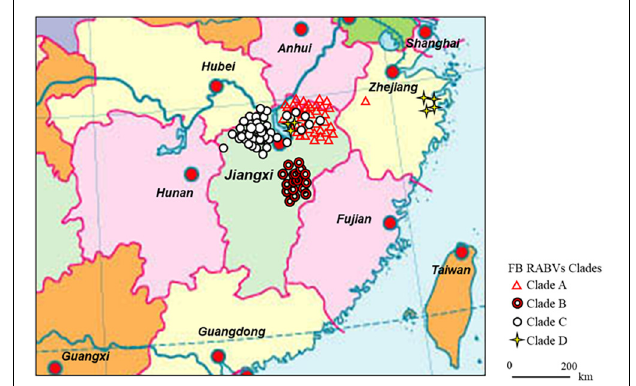
FIGURE 1 | Continental distribution of ferret badger (FB) rabies virus (RABV) isolates in southeast China during 2008–2018. The 41 FB RABV isolates in Lineage A were mainly distributed in Qiandao lake (Zhejiang province) and east Poyang lake (Jiangxi province) regions. Lineage B had 17 isolates from Fuzhou district, south of Poyang lake. Lineage C included 47 isolates, 41 distributed in west Poyang lake, and the other 6 in east Poyang lake, mixing geographically with Lineage A. Lineage D had 4 isolates in Taizhou district, Zhejiang province and 3 in east Poyang lake.